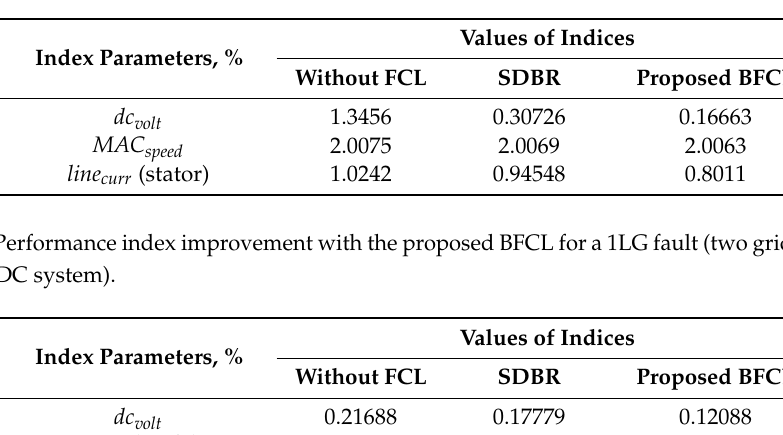
Performance index improvement with the proposed BFCL for a symmetrical fault (wind farm-integrated VSC-HVDC system).